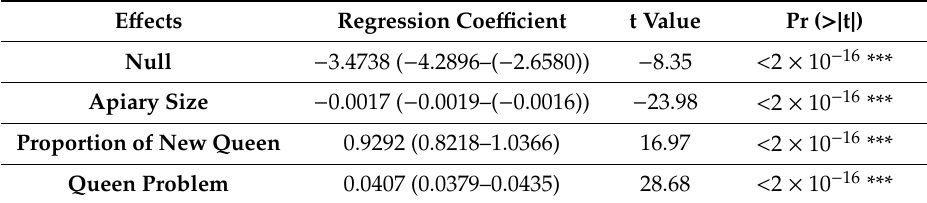
Table 3. Analysis of fixed e ff ects in the final